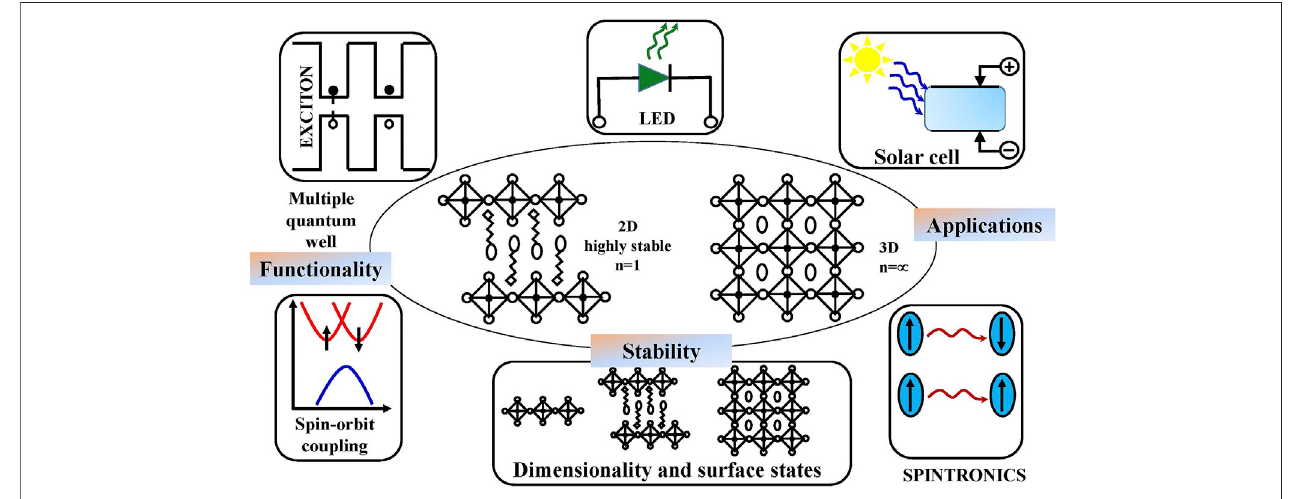
FIGURE 7 | Schematic representation of stability and functionality of 2D